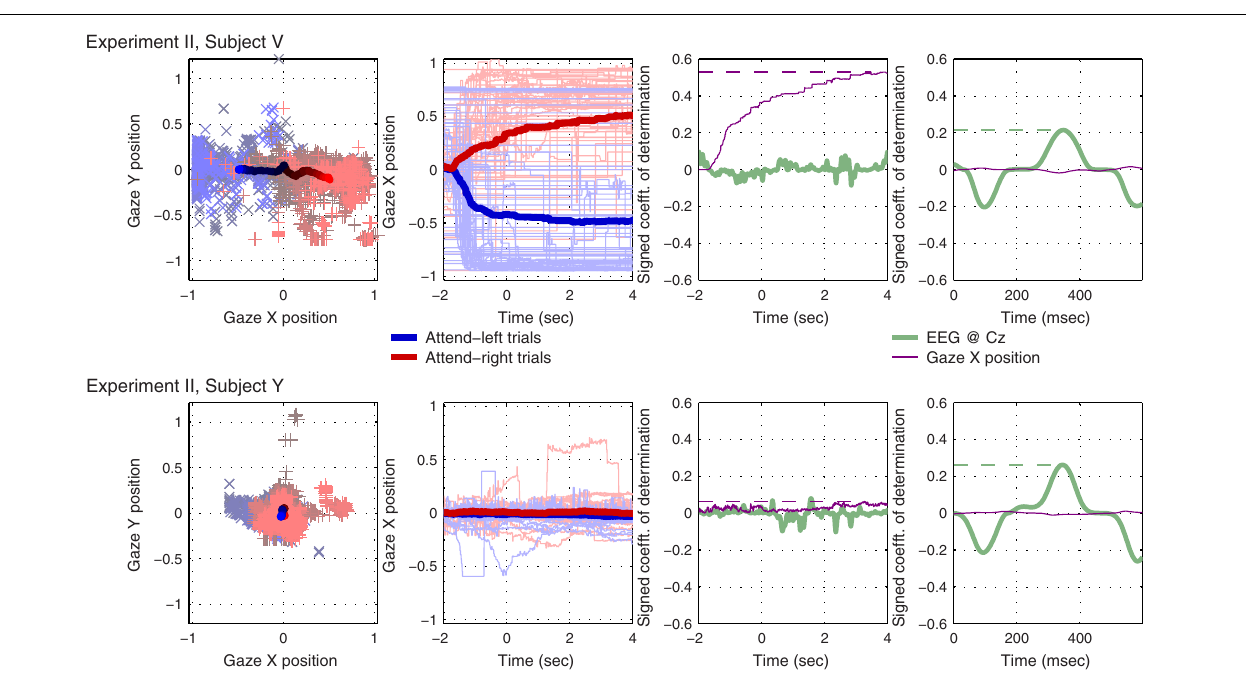
t =− 2s, and the sound stimuli started at t = 0. Again, attend-right trials are plotted in red, attend-left trials in blue, and the mean-across-trials, within each class, is plotted as a thick line. Individual trials are plotted as thin, paler lines. In the third graph, we see a measure of single-trial separability, the signed coefficient-of-determination (signed r 2 ) as a function of time across the whole trial, for both the EEG signal at Cz (green) and horizontal gaze position (purple). Finally, in the fourth graph, we see signed r 2 values for both Cz and horizontal gaze position, this time after preprocessing as described in Section